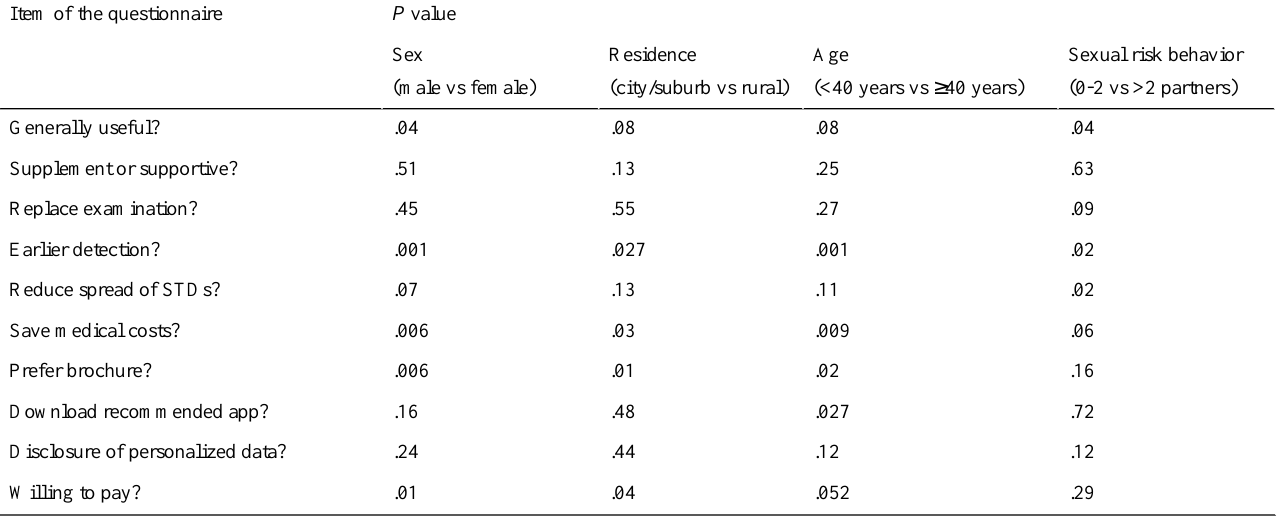
Table 2. Association between sociodemographic data and attitude toward STD-related apps.